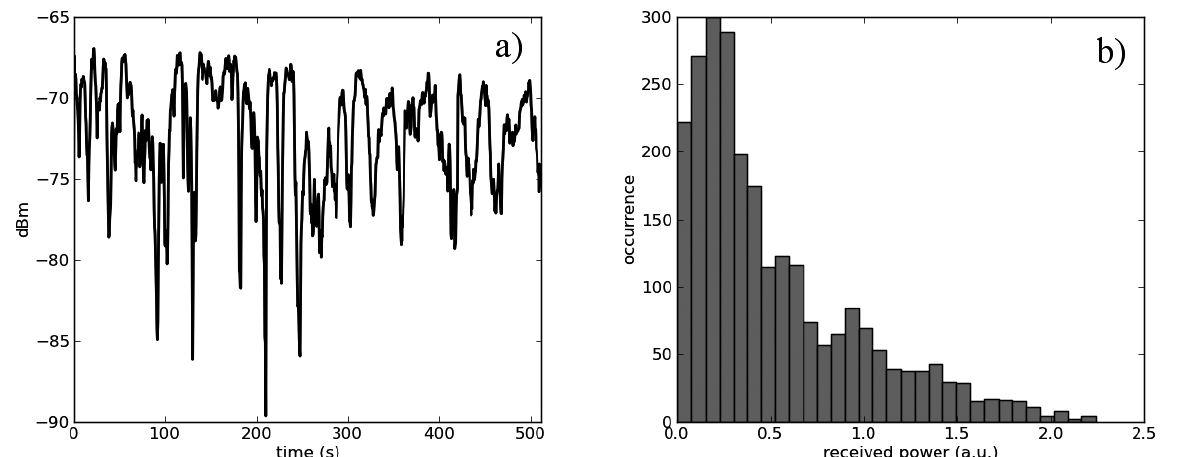
Figure 4. (a) Power observations of the radio echo reflected from the ionosphere on January 7, 2008, at 12:25 UT; (b) corresponding Rayleigh probability density distribution.